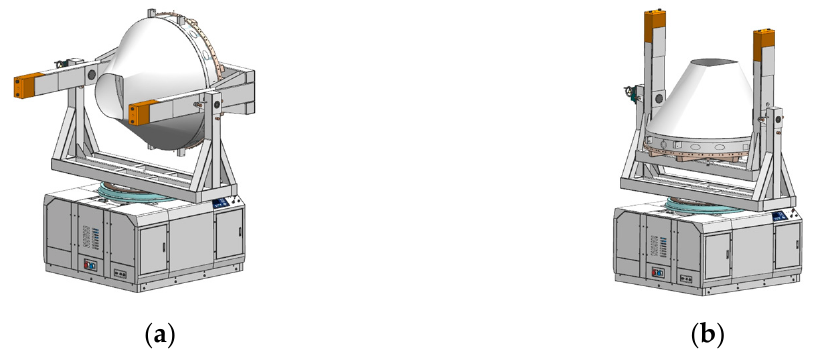
Figure 3. ( a ) Overall effect of the equipment—horizontal state; ( b ) overall effect of the equipment—vertical state.